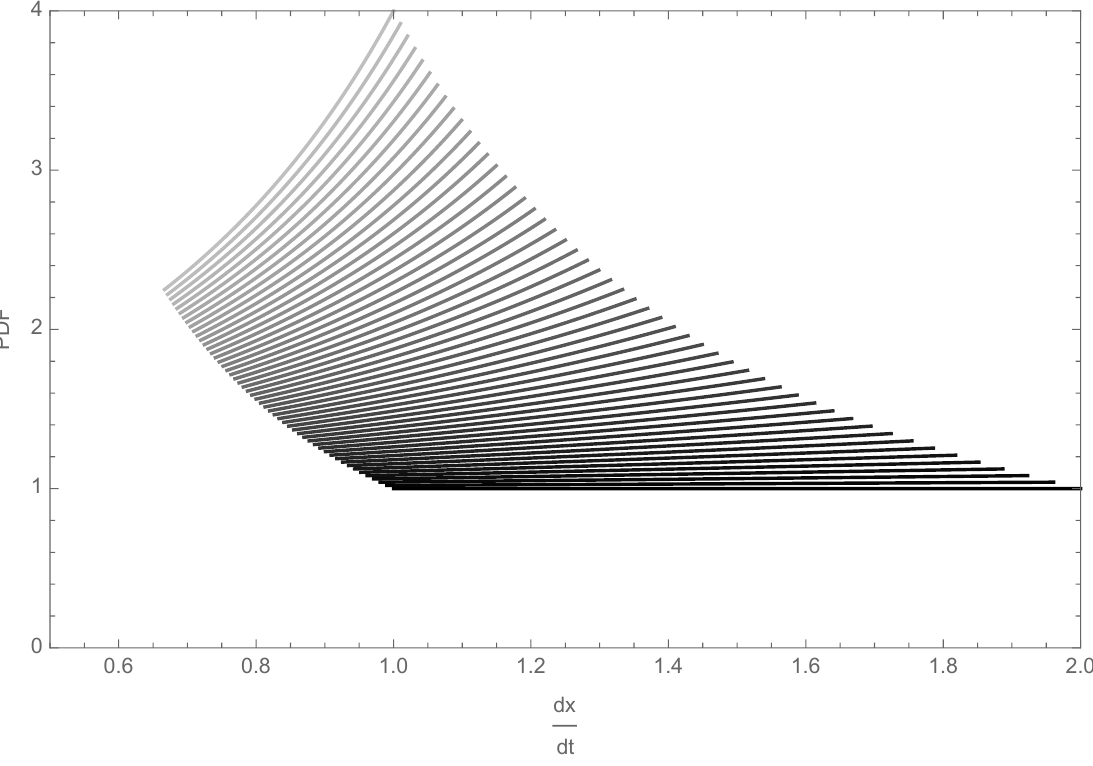
FIG. 2: The probability density function for our toy model varies over time (shades of grey) showing the evolution of a uniform distribution at t = 1 (black) to a re-weighted distribution at t = 2, following the shape of the expansion of the interval in e x seen in the phase space